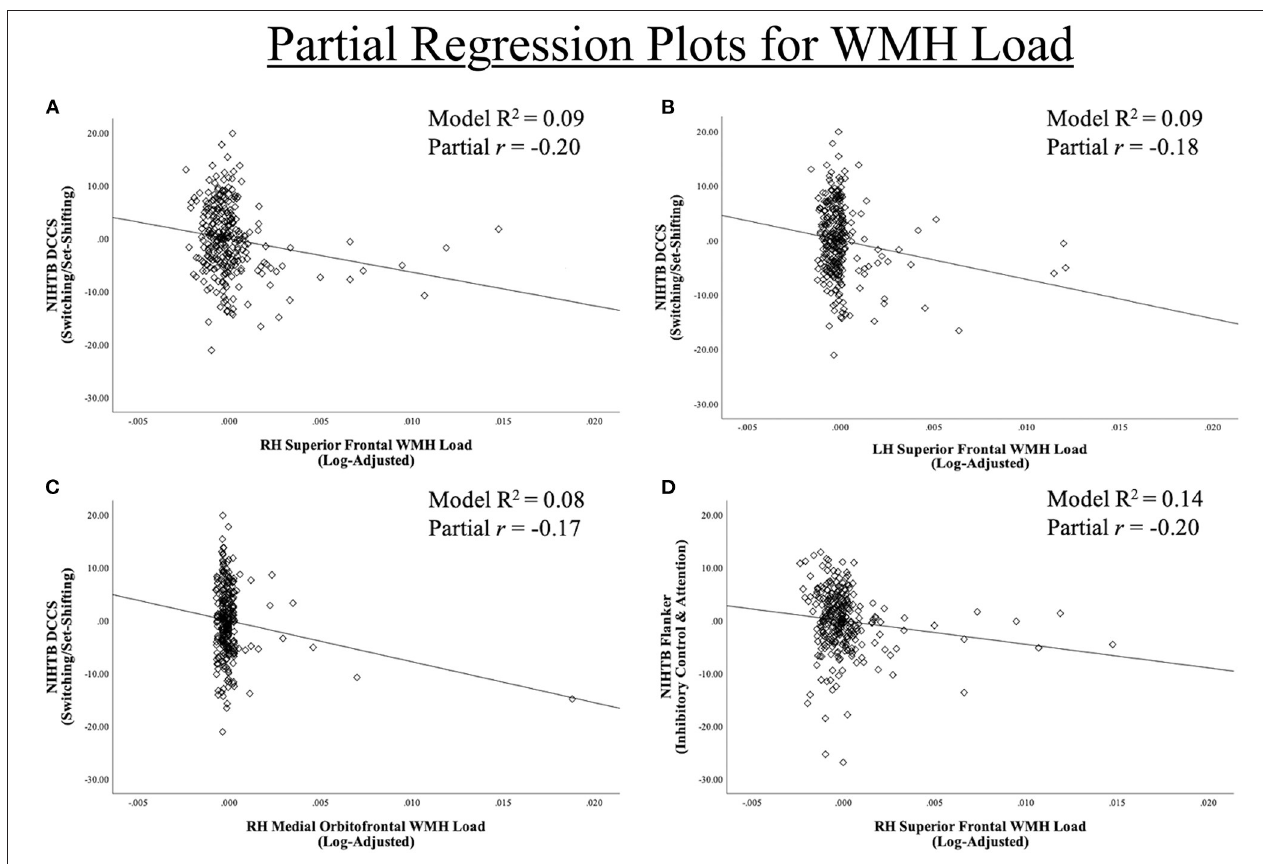
FIGURE 4 | Region-Specific WMH ROIs significant for (A–C) dimensional change card sort test and (D) Flanker inhibitory control and attention test. Partial regression scatter plots for relationships between NIHTB DCCS and Flanker performance and significant Desikan-Killiany frontal regions WMH load for (A) left hemisphere superior frontal, (B,D) right hemisphere superior frontal, (C) right hemisphere medial